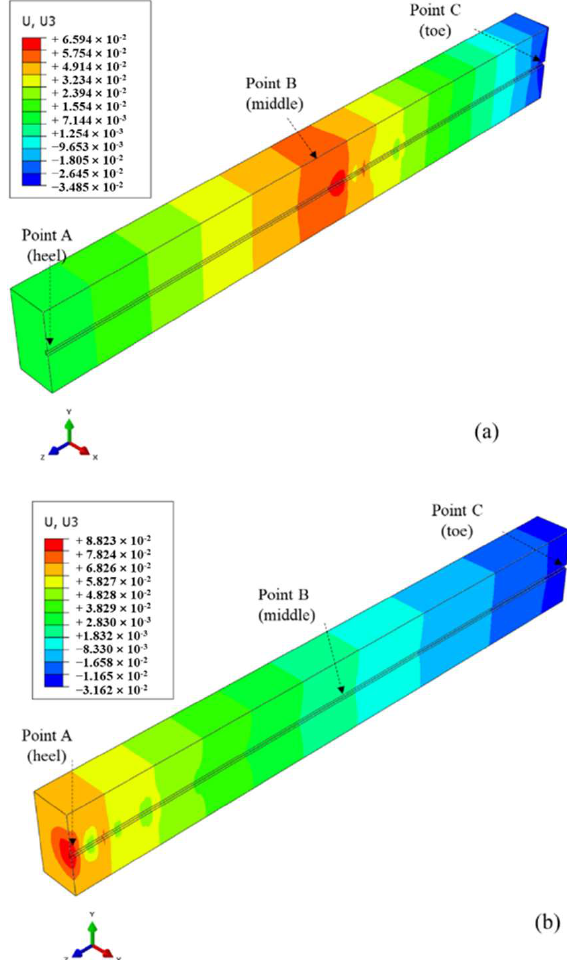
Figure 9. Axial displacement cloud diagram of strata: ( a ) 12th fracturing; ( b ) 23rd fracturing.